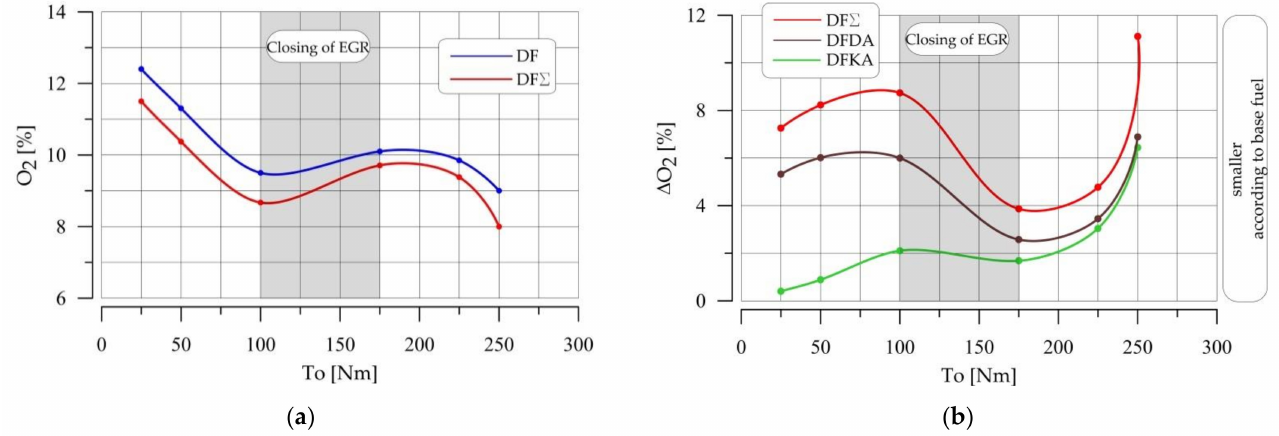
Figure 9. ( a ) Oxygen concentration in the exhaust fumes vs. engine torque; ( b ) Percentage difference in the values of oxygen concentration in the exhaust fumes vs. engine torque in relation to the base